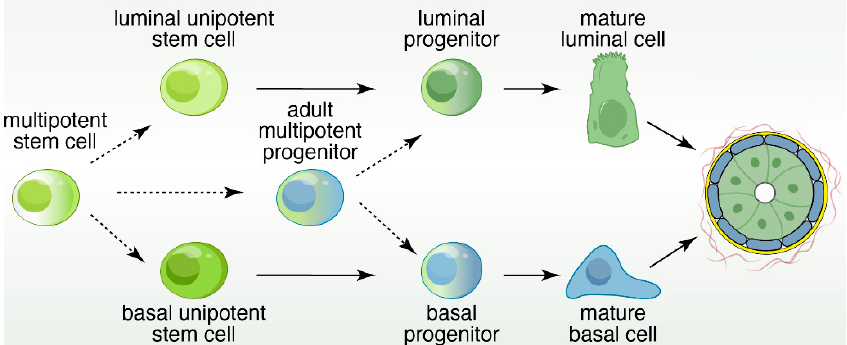
Figure 3. Schematic of the developmental hierarchy in the mammary gland. It should be explicitly stressed that Figure 3 is a model. In this hierarchy, mature luminal cells and mature basal cells are maintained by lineage-restricted, unipotent progenitors, which are replenished by multipotent stem cells that are present during embryogenesis.